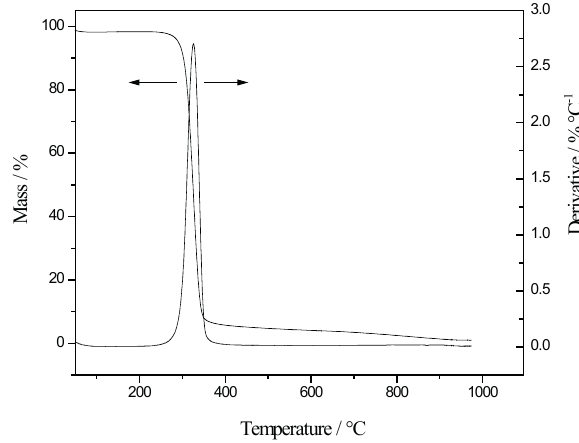
Figure 5: Thermogravimetric curve and the derivative of cellulose.